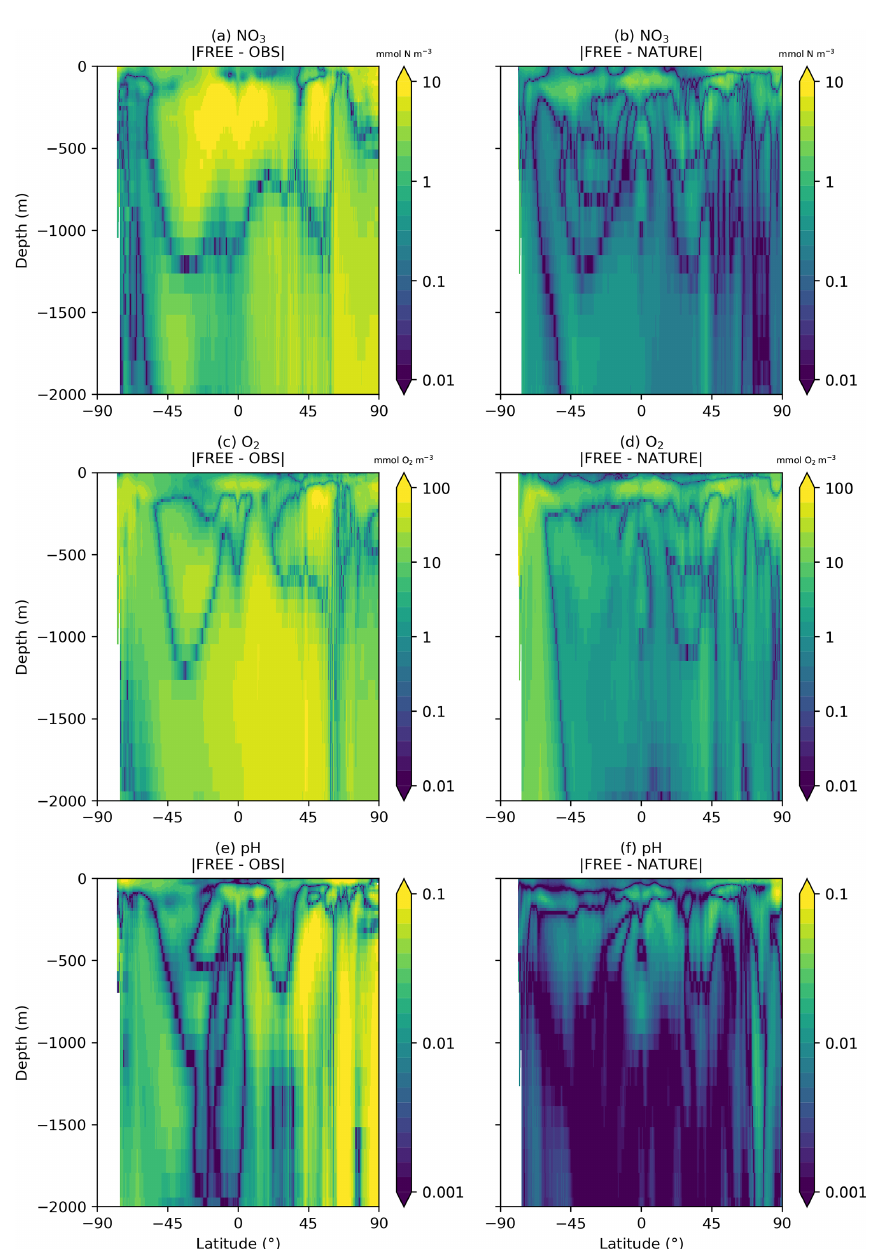
Figure 5. Absolute difference between FREE and real-world observation-based products (a, c, e) and between FREE and NATURE (b, d, f) for annual zonal mean sections of (a, b) NO 3 , (c, d) O 2 , and (e, f) pH.